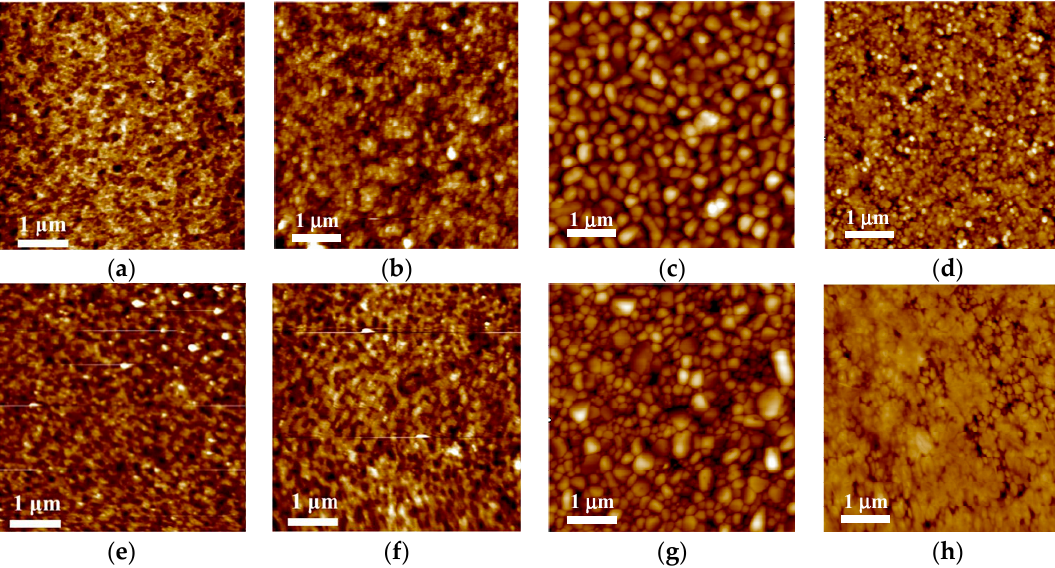
Figure 4. AFM images of ( a ) PEDOT:PSS, ( b ) NiO x NP HTLs, and the EML of ( c ) Device-PA, ( d ) Device-PB, ( e ) Device-PC, ( f ) Device-PD, ( g ) Device-NA, and ( h ) Device-ND.